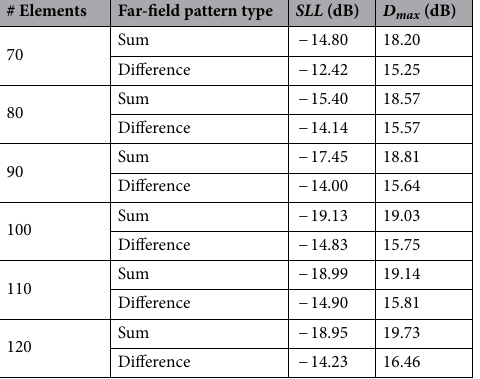
Desired deep null position